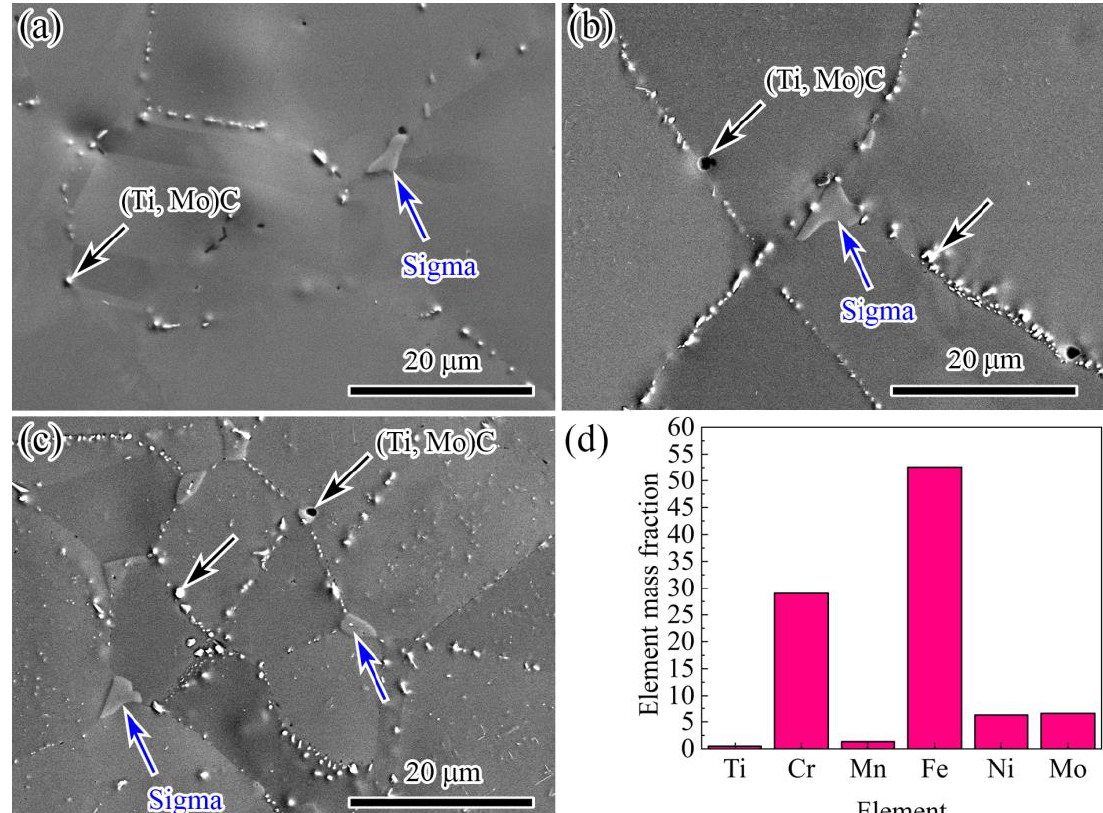
Figure 4. The SEM images of 15Cr–15Ni–Ti–xP alloys after aging at 850 °C for 1000 h: ( a ) 15Cr–15Ni– Ti–70P alloy, ( b ) 15Cr–15Ni–Ti–150P alloy, ( c ) 15Cr–15Ni–Ti–250P alloy and ( d ) SEM-EDS spectrum corresponding to sigma phase.